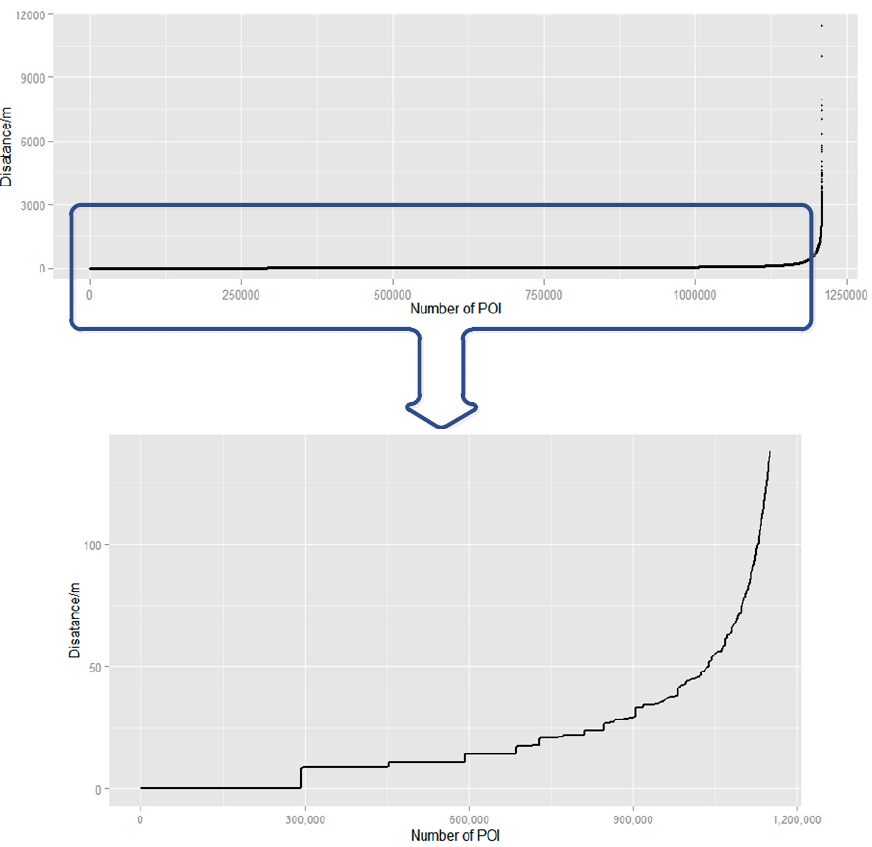
Figure 4. The nearest distances between POIs.